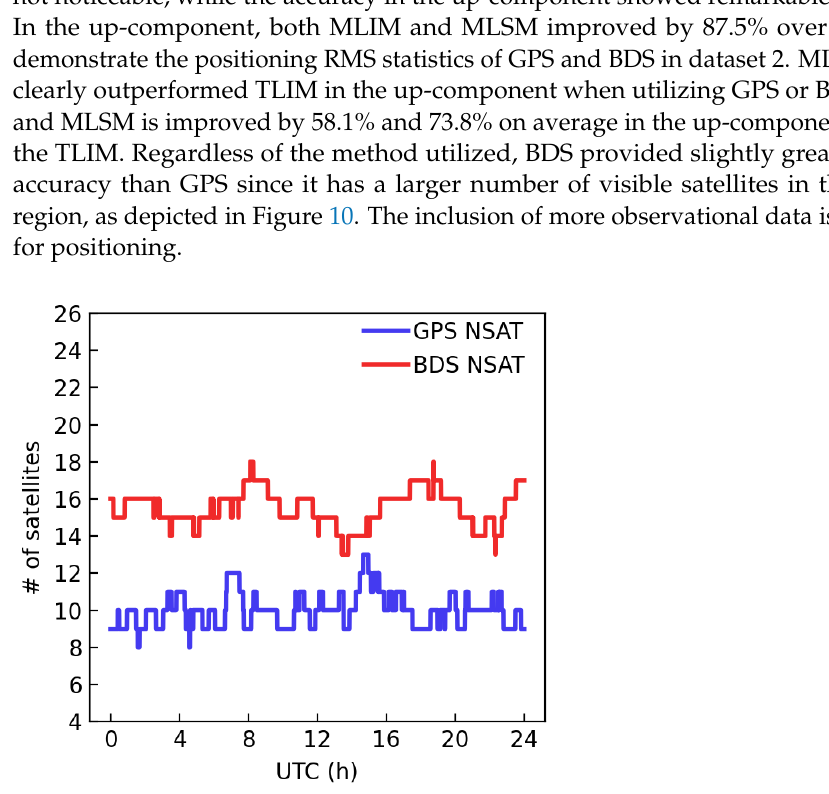
Figure 10. Number of satellites based on GPS and BDS in dataset